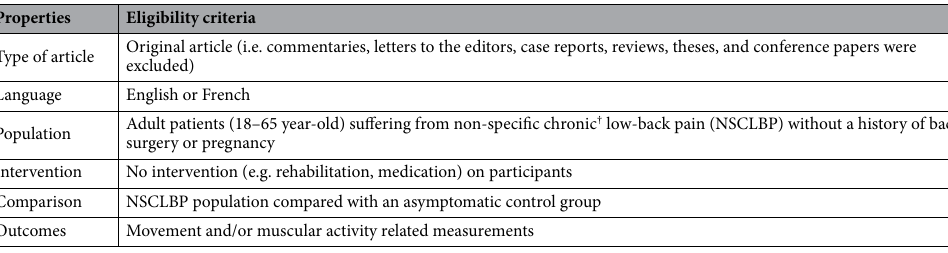
Table 3. Eligibility criteria of the identified studies. † A patient was defined chronic when pain duration was superior or equal to 3